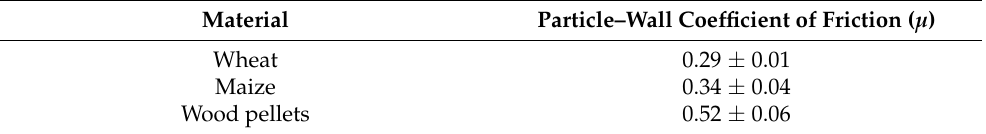
Table 3. Particle–wall coefficient of friction for the three materials examined.